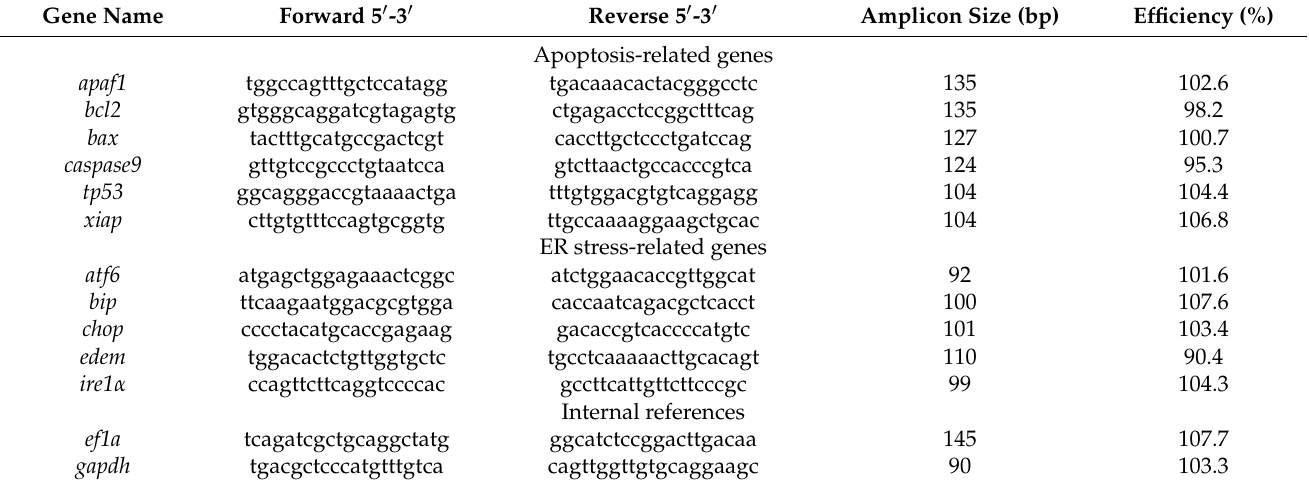
Table 1. Sequence, amplicon size and efficiency of the primers used for qPCR